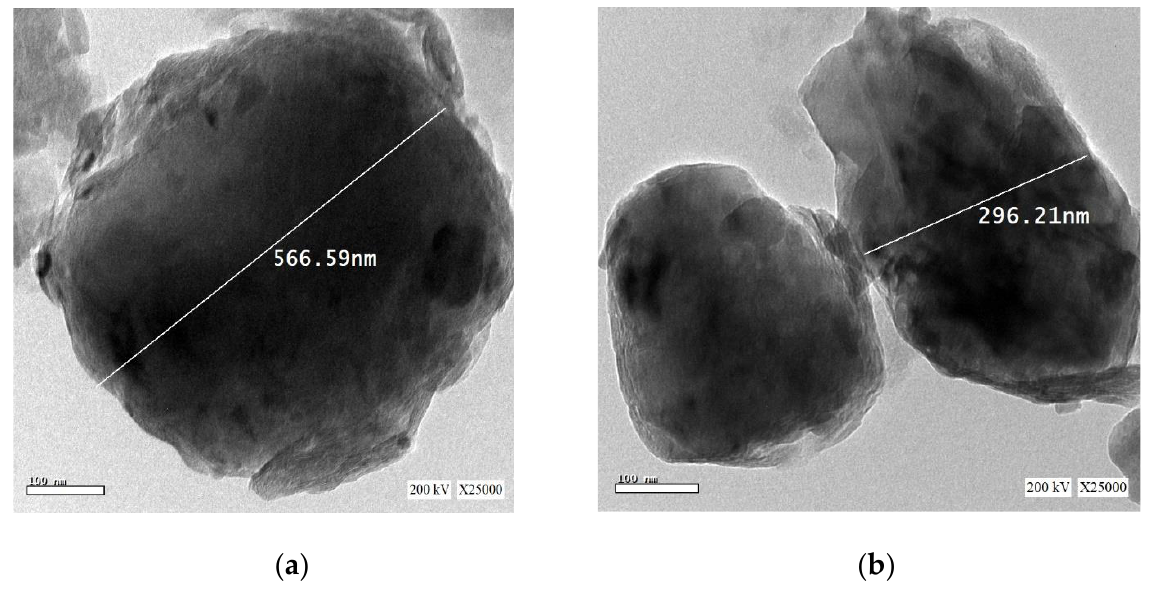
Figure 3. TEM of ( a ) the calcinated bentonite sample ( b ) and the ball-milled calcinated